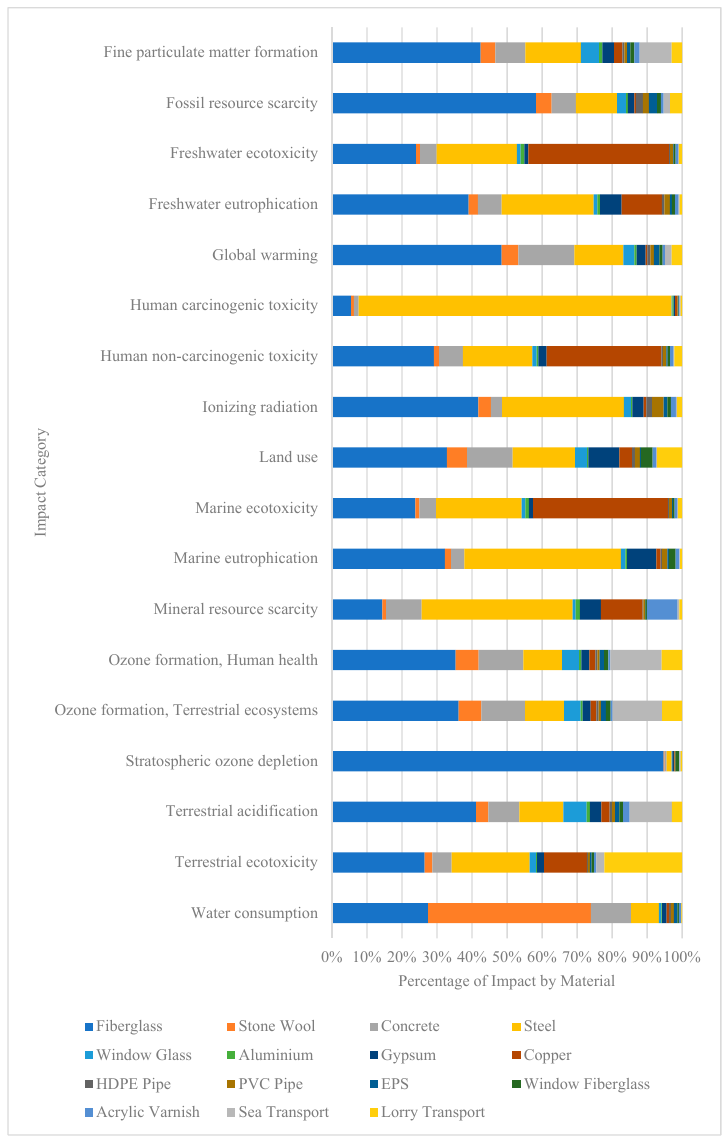
Figure 5. Midpoint hotspot analysis by material. Each color represents the impacts from each mate- rial to the18 midpoint impact categories.